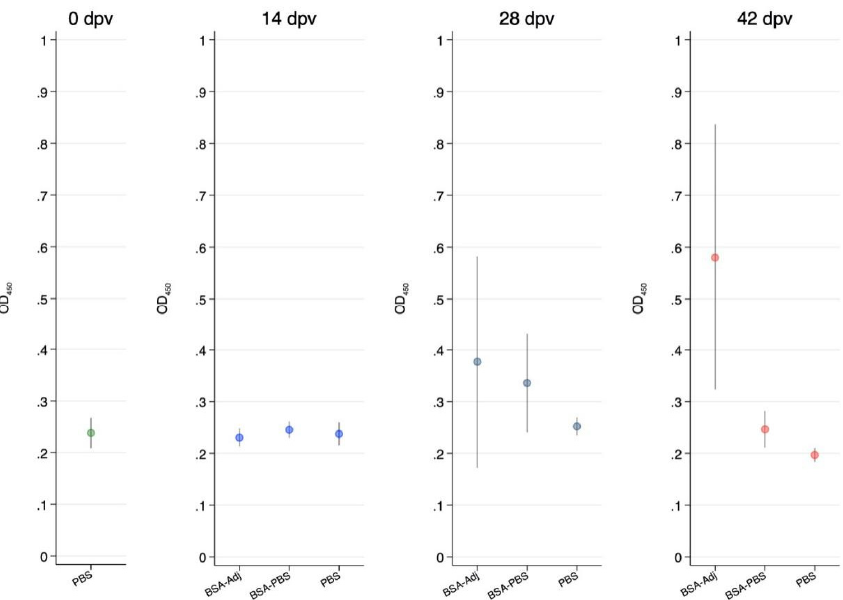
Figure 2. Serum anti ‐ IgM antibody response of Chinese soft ‐ shelled turtles at 0, 14, 28 and 42 days post vaccination (dpv) for phosphate buffered saline (PBS), bovine serum albumin (BSA)/PBS and BSA/adjuvant groups. Average and 95% confidence limits are shown for each group at each time post vaccination.